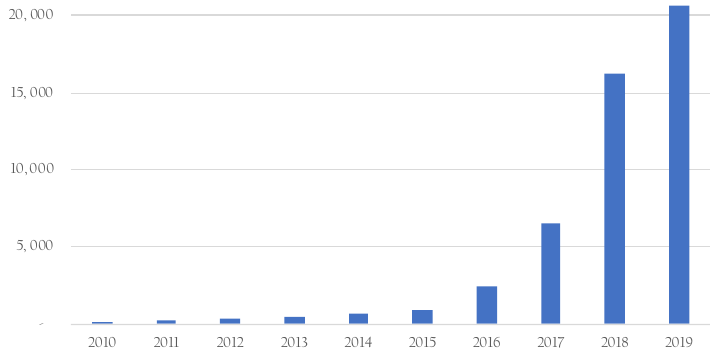
Figure 6. Secure Internet server in Poland (World Bank database).